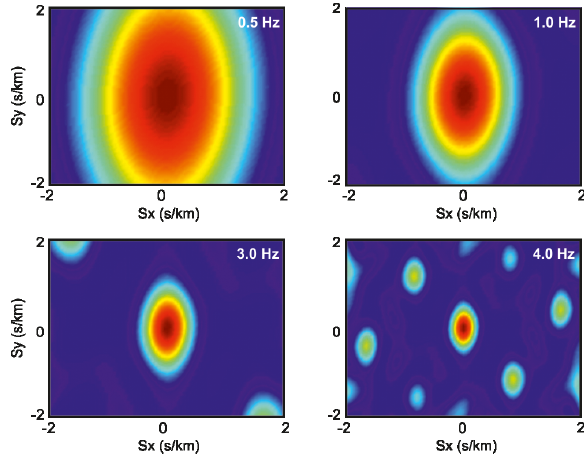
Figure 3. Array response computed for a vertically incident wave at four different